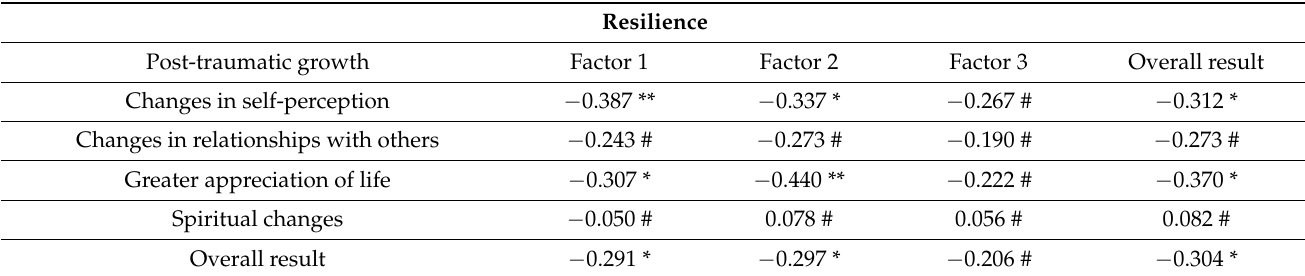
Table 5. The values of the correlation coefficient of alexithymia with post-traumatic growth in a recipient from a cadaveric donor.